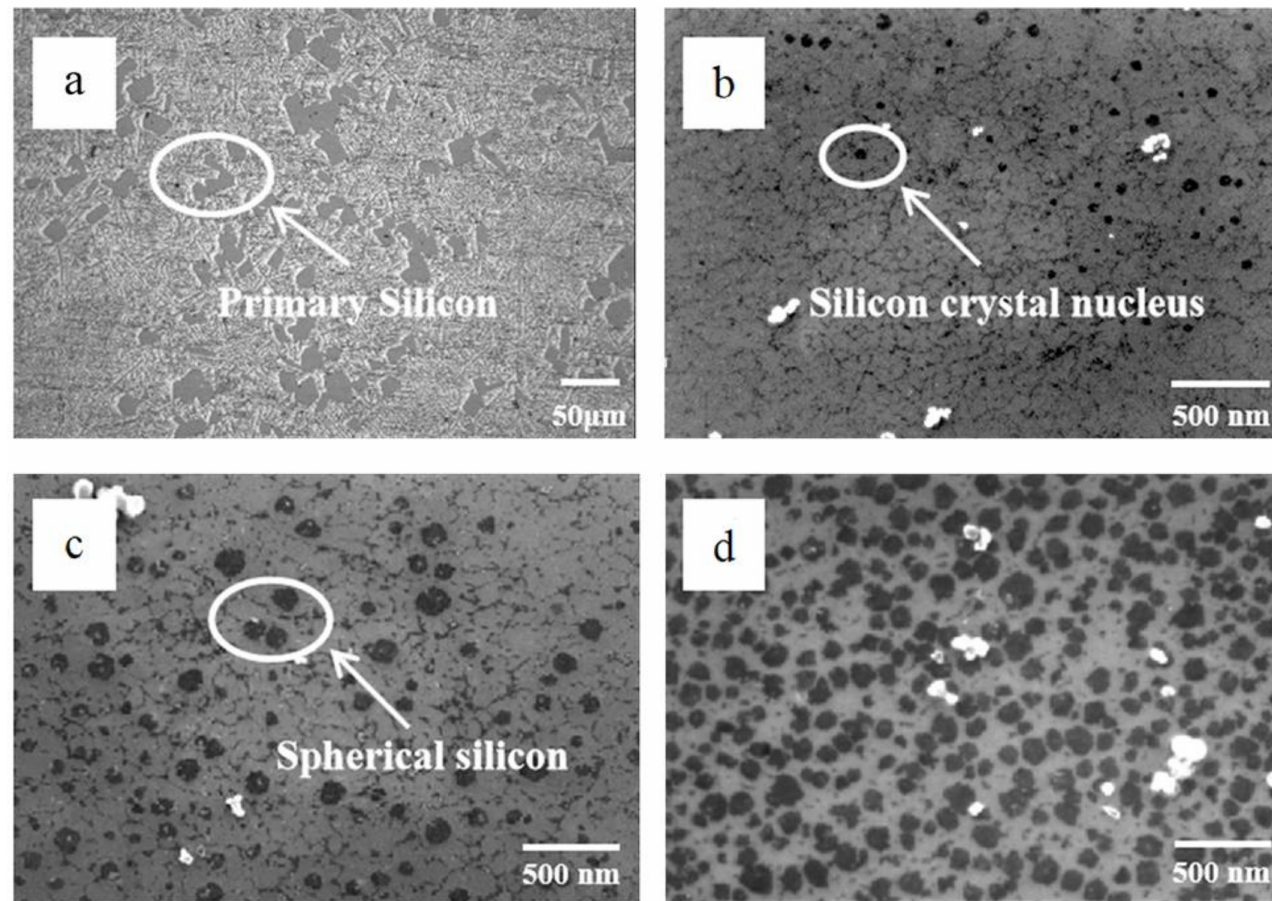
Figure 2. Spheroidization process of nano-primary silicon. ( a ) Initial stage, original specimen; ( b ) Nucleation stage; ( c ) Growth stage; ( d ) Formation